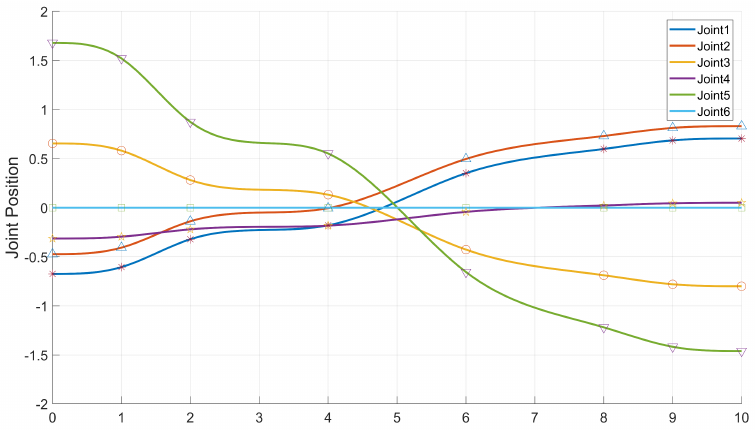
Figure 14. The joint position change curve of the AUBO − i5 when performing the picking task.